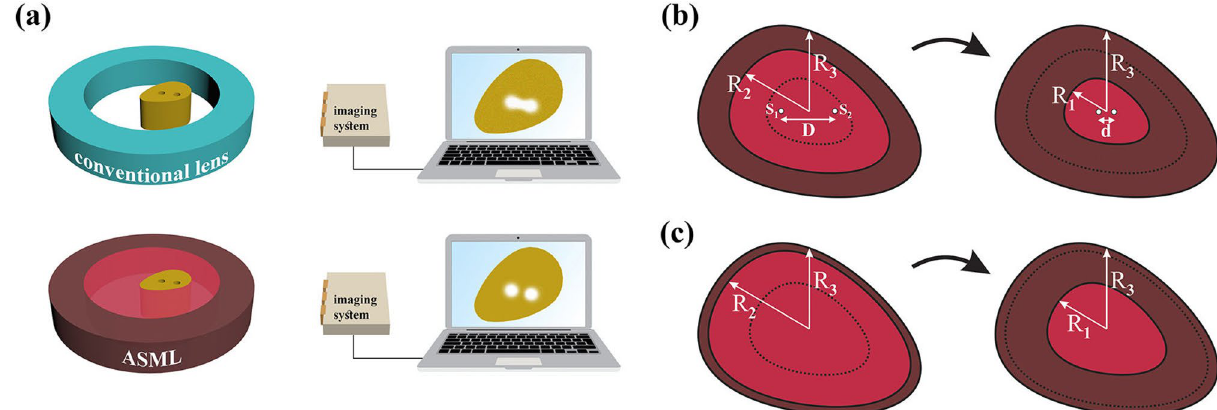
Figure 1. ( a ) The schematic of potential application of ASML in sub-wavelength imaging devices. ( b ) The demonstration of the coordinate transformation. ( c ) The corresponding coordinate transformation when h 2 h 3 →